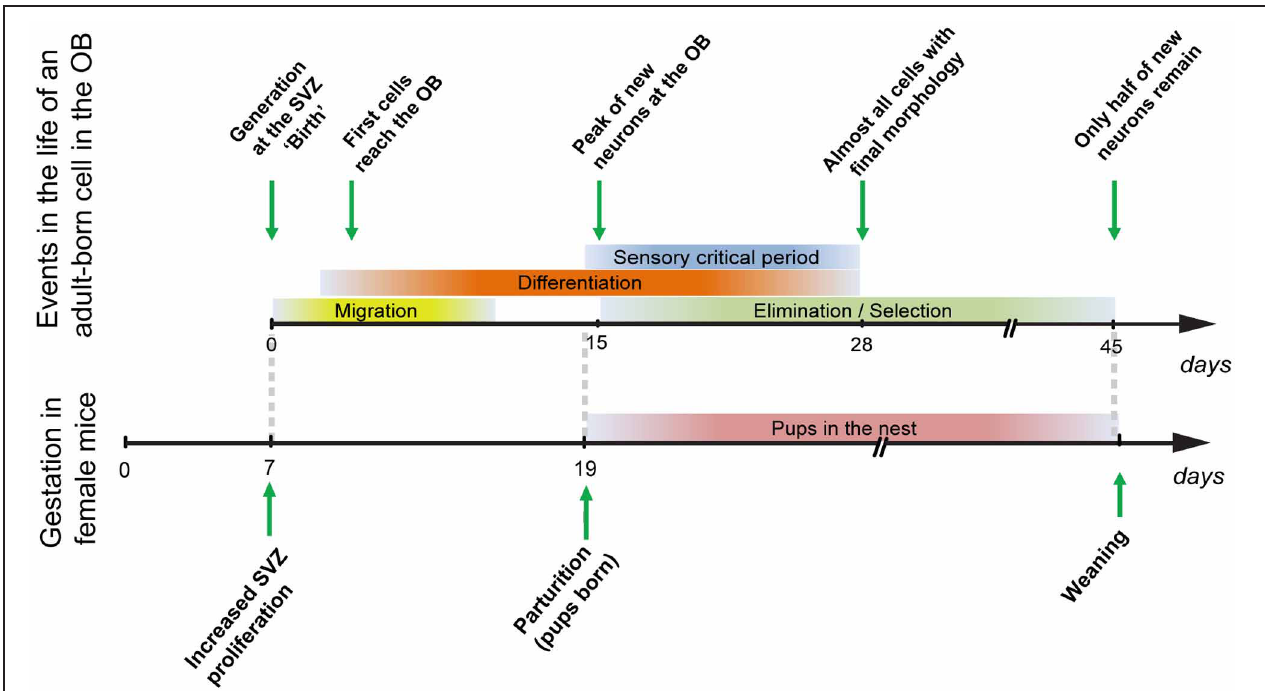
FIGURE 1| Maturation, differentiation, and selection of adult-generated OB cells (top) in comparison to the events occurring during gestation in female mice. Cells that are generated during gestation (day 7;